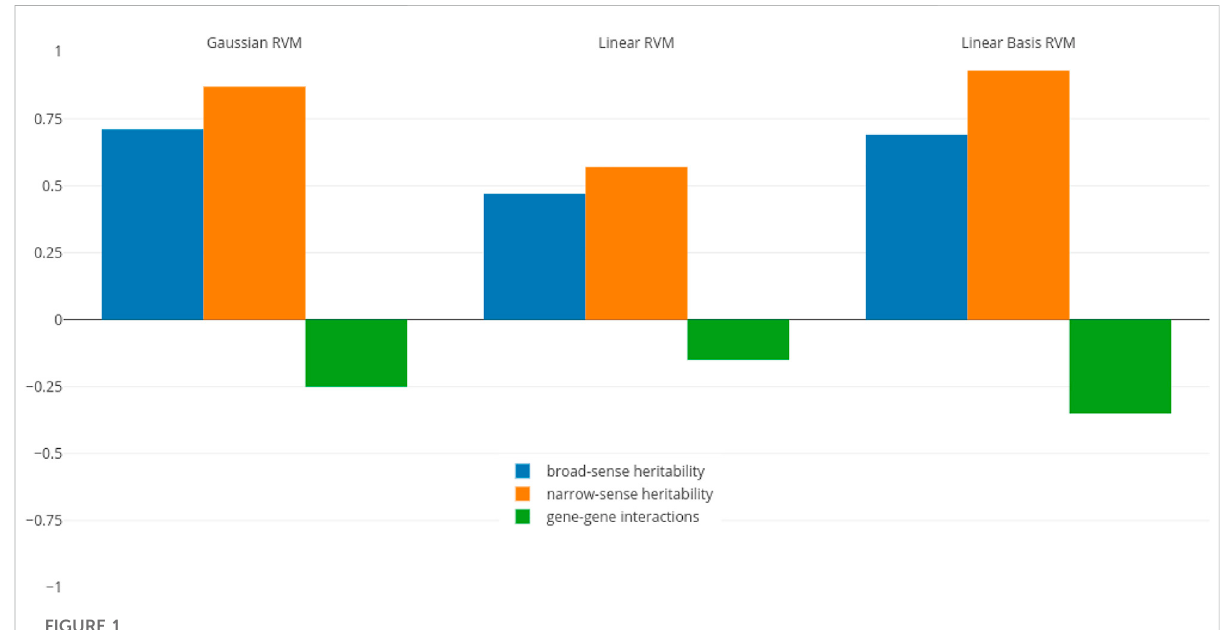
FIGURE 1 Pearson correlation coef fi cient between RVM accuracies and different heritability